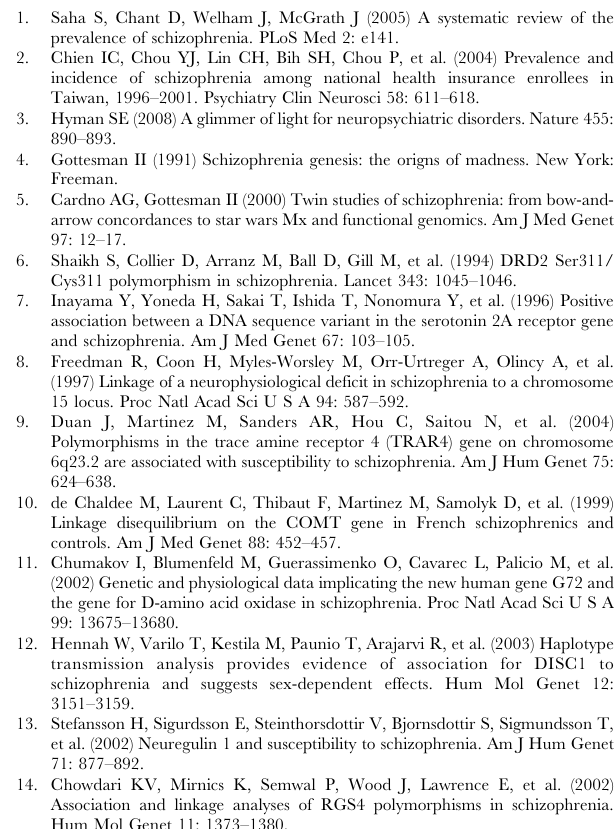
Table S4 Testing TRS association results with schizophrenia. Table S5 SNPs showing suggestive significant associations adjusted using genomic control. Table S6 Previously reported loci and SNPs associated with schizophrenia.